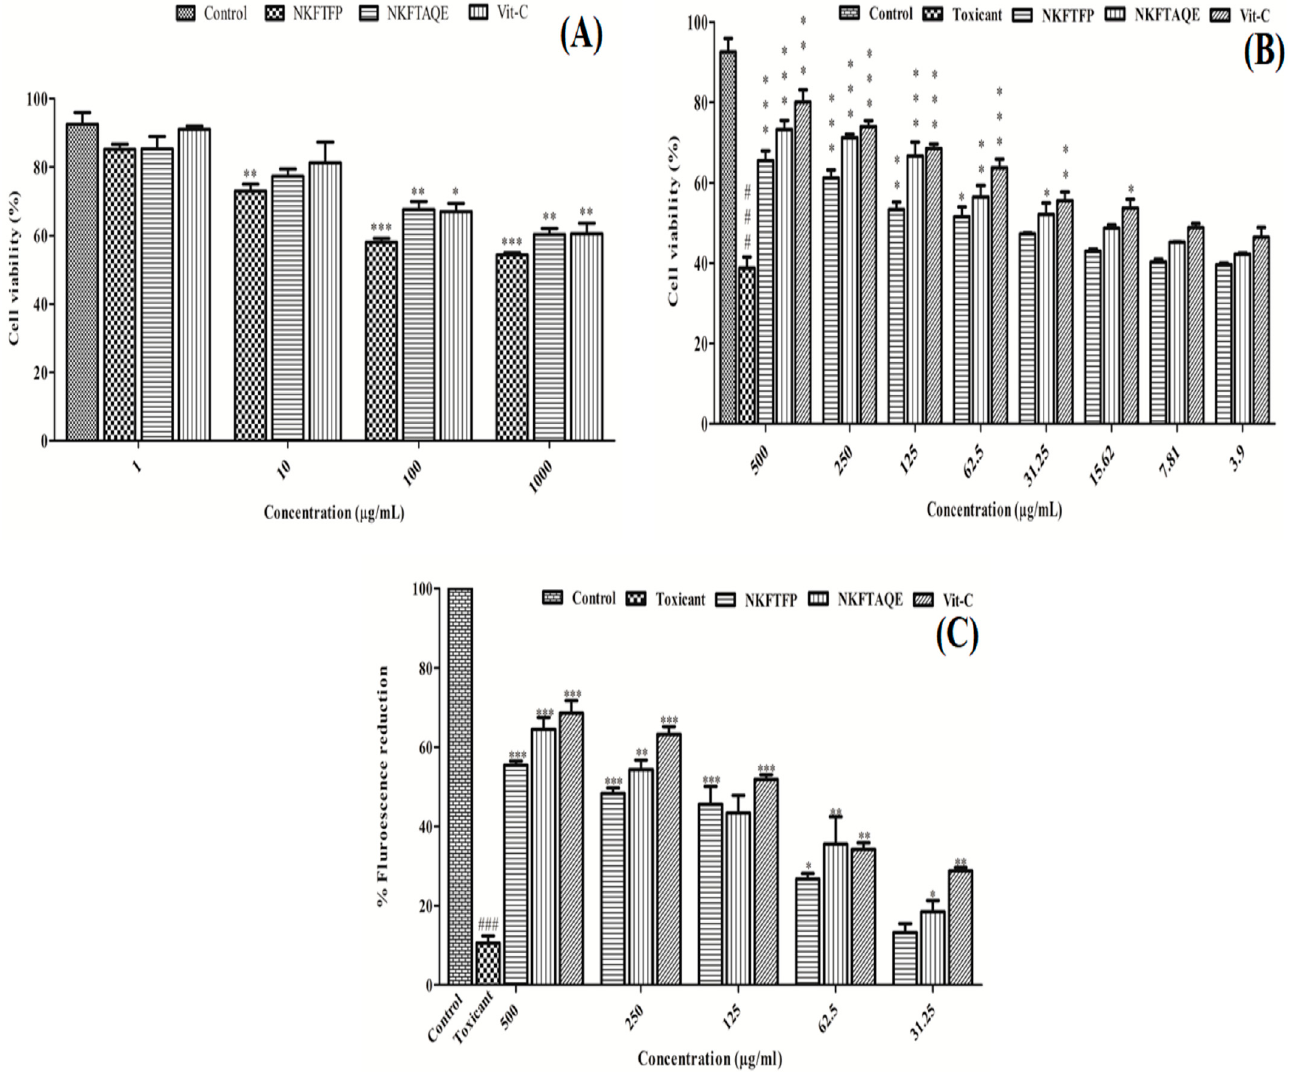
Figure 4. Cytotoxicity ( A ), nephroprotective ( B ) and cellular antioxidant potential ( C ) of NKFTFP and NKFTAQE on HEK 293 cells. The statistical representations are shown as mean ± SD ( n = 3) using one-way ANOVA followed by the Tukey test. The comparisons are made between the control group to toxicant group, toxicant group to drug-treated group. The statistical significance level is expressed at * p < 0.05 (less significant), ** p < 0.01 (significant) and ###/*** p < 0.001 (high significant). The data represented by the ‘*/**/***’ showed statistical difference in the activity as compared to the toxicant group.